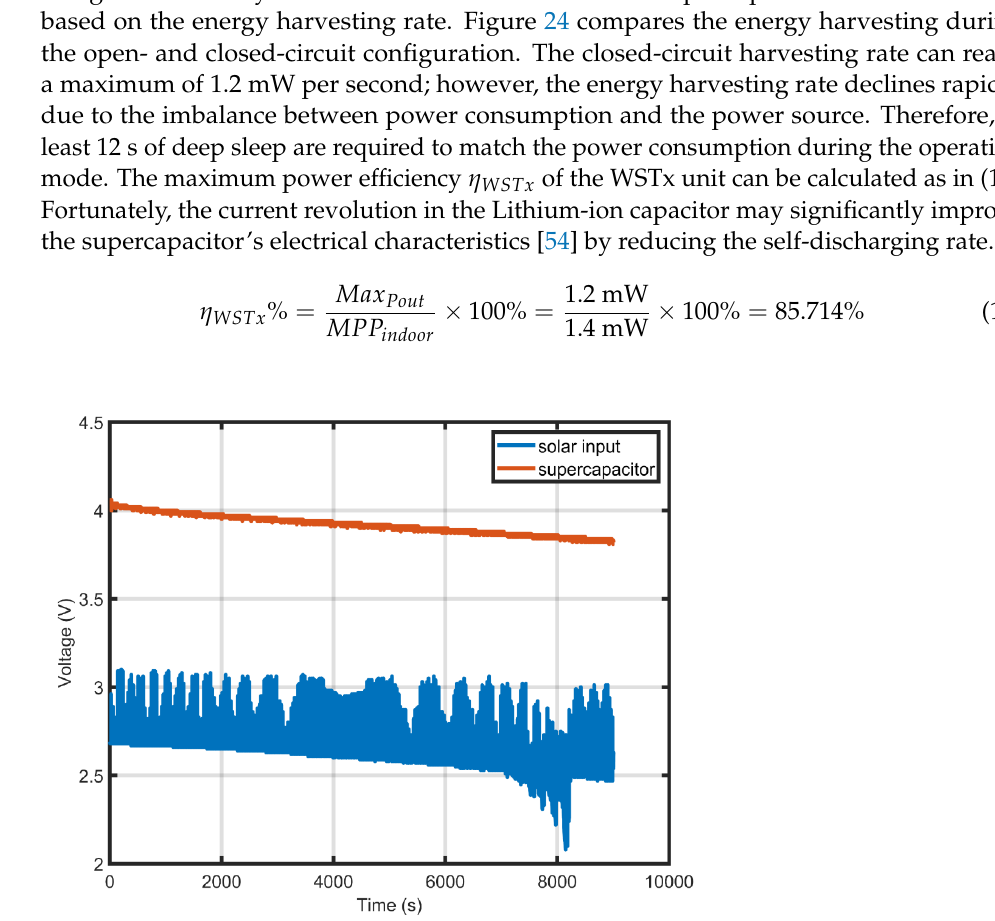
Figure 23. Voltage drop rate during the harvesting (closed-circuit).